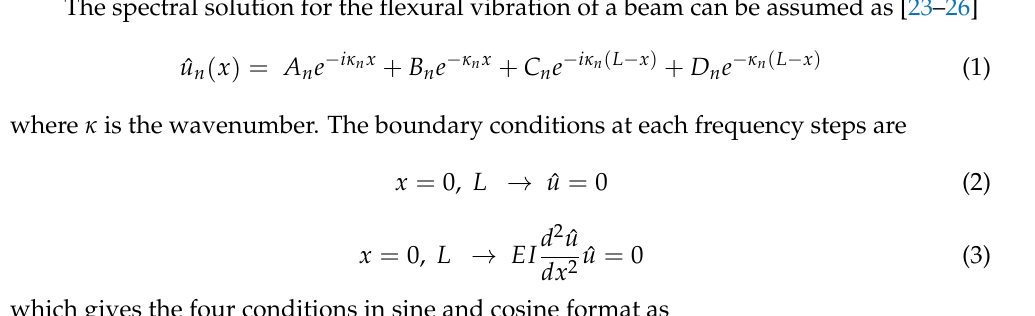
Figure 6. Simply supported beam.